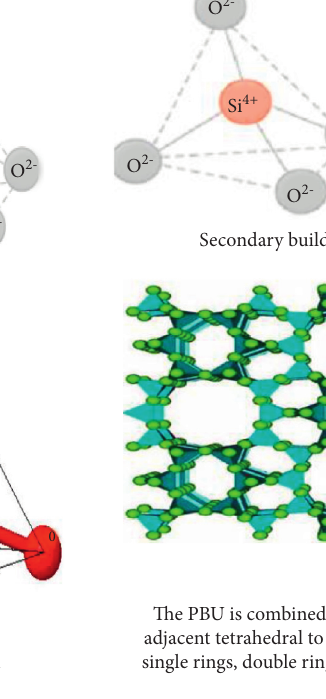
Figure 1: Primary and secondary building units of zeolites adopted from the work of Moshoeshoe et al. [4] and Mgbemere and Ekpe